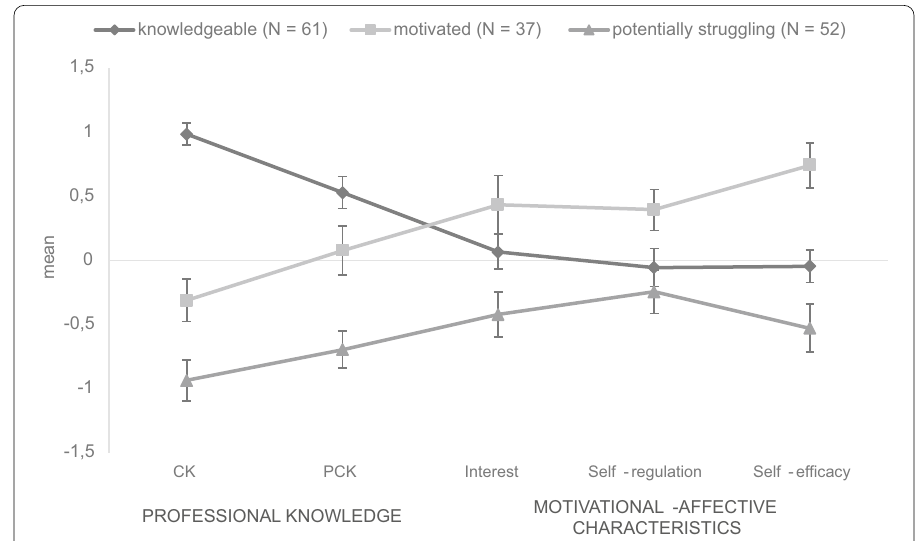
Fig. 1 Mean values and standard deviations of the three profiles regarding z-standardized LPA indicators